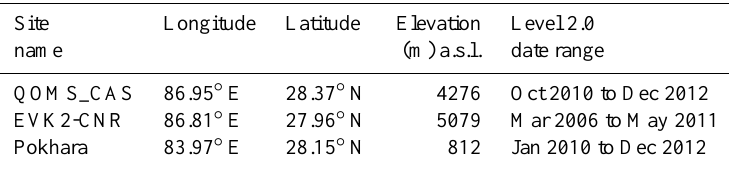
Table 1. The basic information of all three AERONET sites (QOMS_CAS, EVK2-CNR and Pokhara) includes longitude, latitude, elevation, and date ranges of the level 2.0 data.